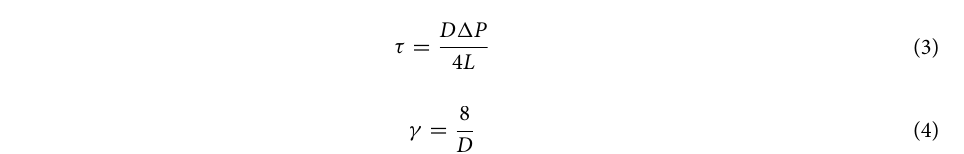
Figure 5. Optical microscope images of the analogue demonstrating examples of the Sc-CO 2 and aqueous two- phase flows for ( a ) Duomeen TTM, ( b ) Toximul TA-8 both at 0.5 wt% in Brine 1; 70% foam quality and ( c ) CO 2 and Brine 1 without surfactants; 30% foam